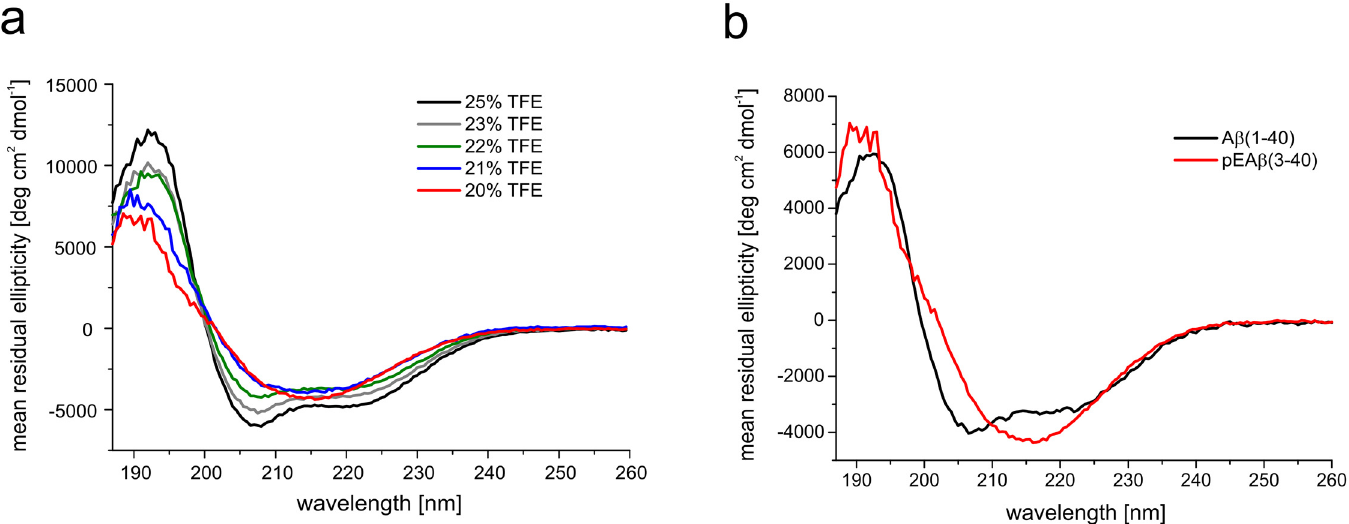
Fig 1. Far-UV CD spectra of pEA β (3 – 40) and A β (1 – 40). Peptides were dissolved in buffer (20 – 25% TFE in 50 mM potassium phosphate, pH 2.8). CD spectra were recorded at 20°C from 260 to 187 nm, accumulated 10 times and background corrected. (a) CD spectra of 25 μ M pEA β (3 – 40) in 25%, 23%, 22%, 21% and 20% TFE showed a shift from α -helical structure towards β -sheets with decreasing TFE concentrations. (b) The CD spectrum of 25 μ M A β (1 – 40) indicated α -helices in 20% TFE while the spectrum of 25 μ M pEA β (3 – 40) in 20% TFE showed mainly β -sheet rich structures.